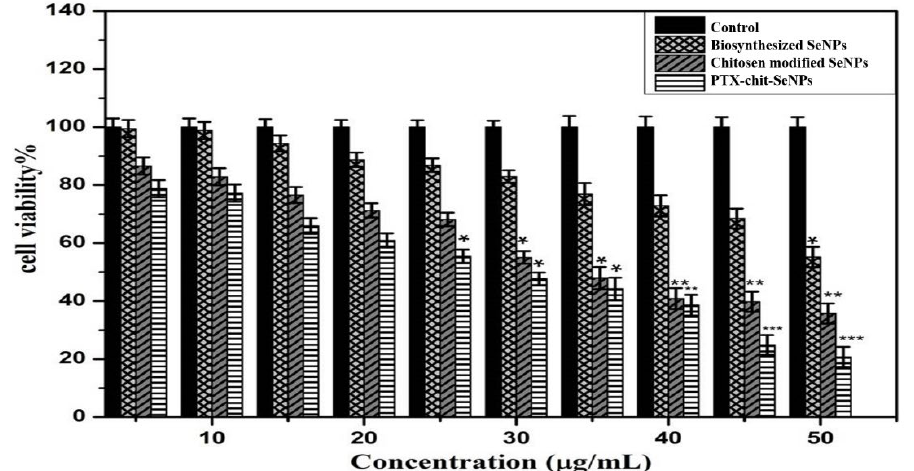
Figure 8. MTT analysis for biosynthesized SeNPs, chitosan-modified SeNPs, and PTX-chit-SeNPs against HeLa cell lines. Data are represented as mean ± SD for experiment in triplicate * indicates p < 0.05 versus control, ** indicates p < 0.01, and *** indicates p < 0.001.